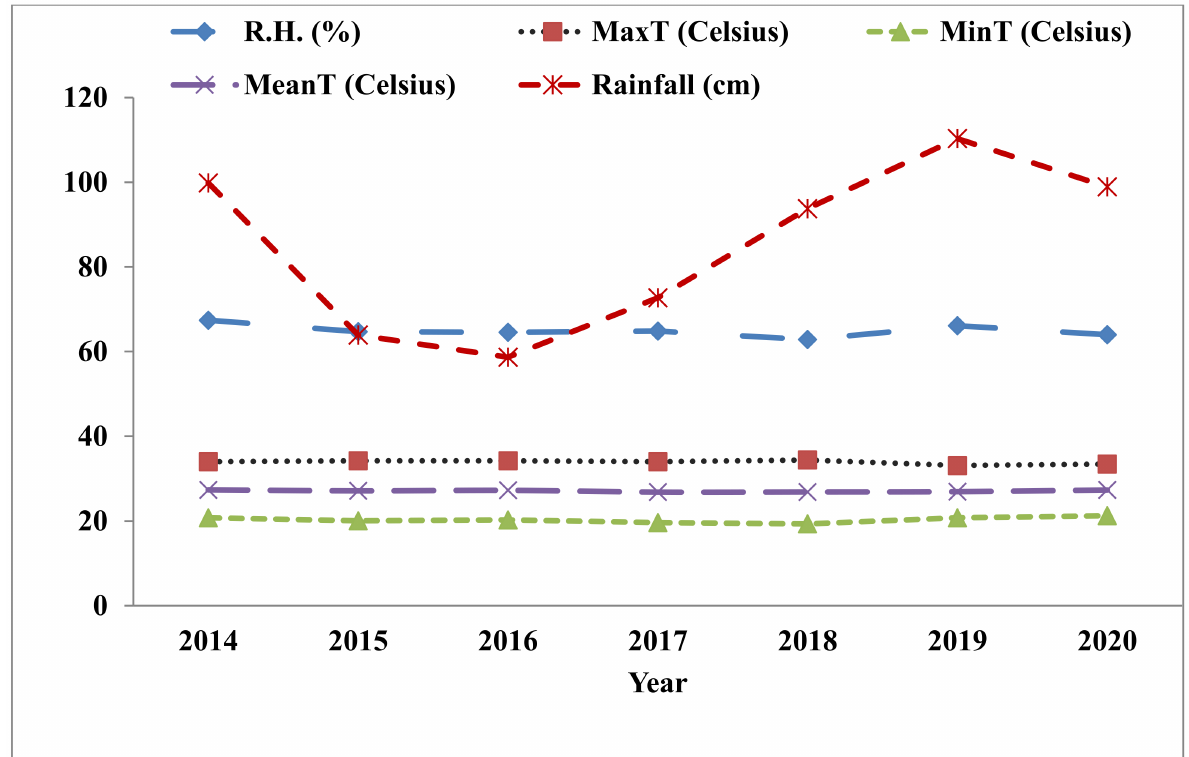
Figure 2. Temperature, rainfall and relative humidity of the experimental area during study